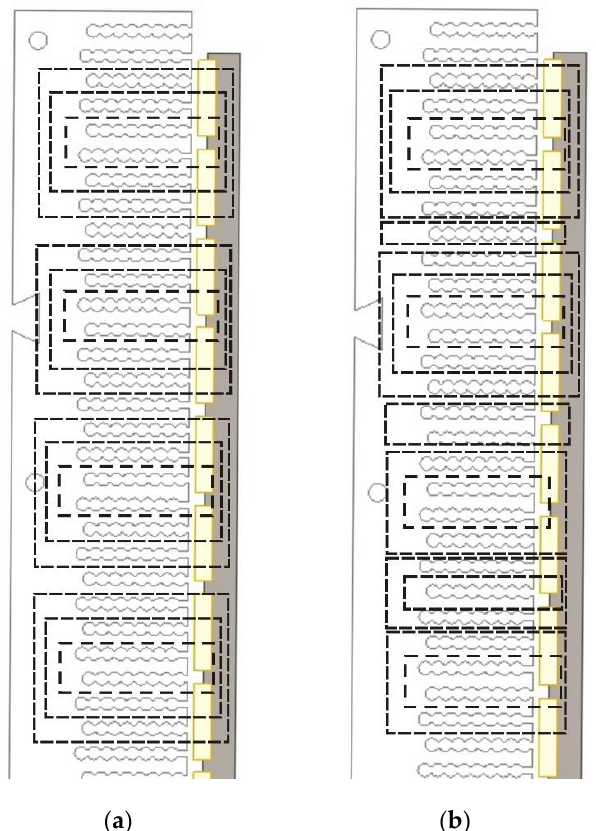
Figure 3. ( a ) The pair wise grouped flux with an even number of active magnets contra ( b ) the flux distribution with an odd number of active magnets.